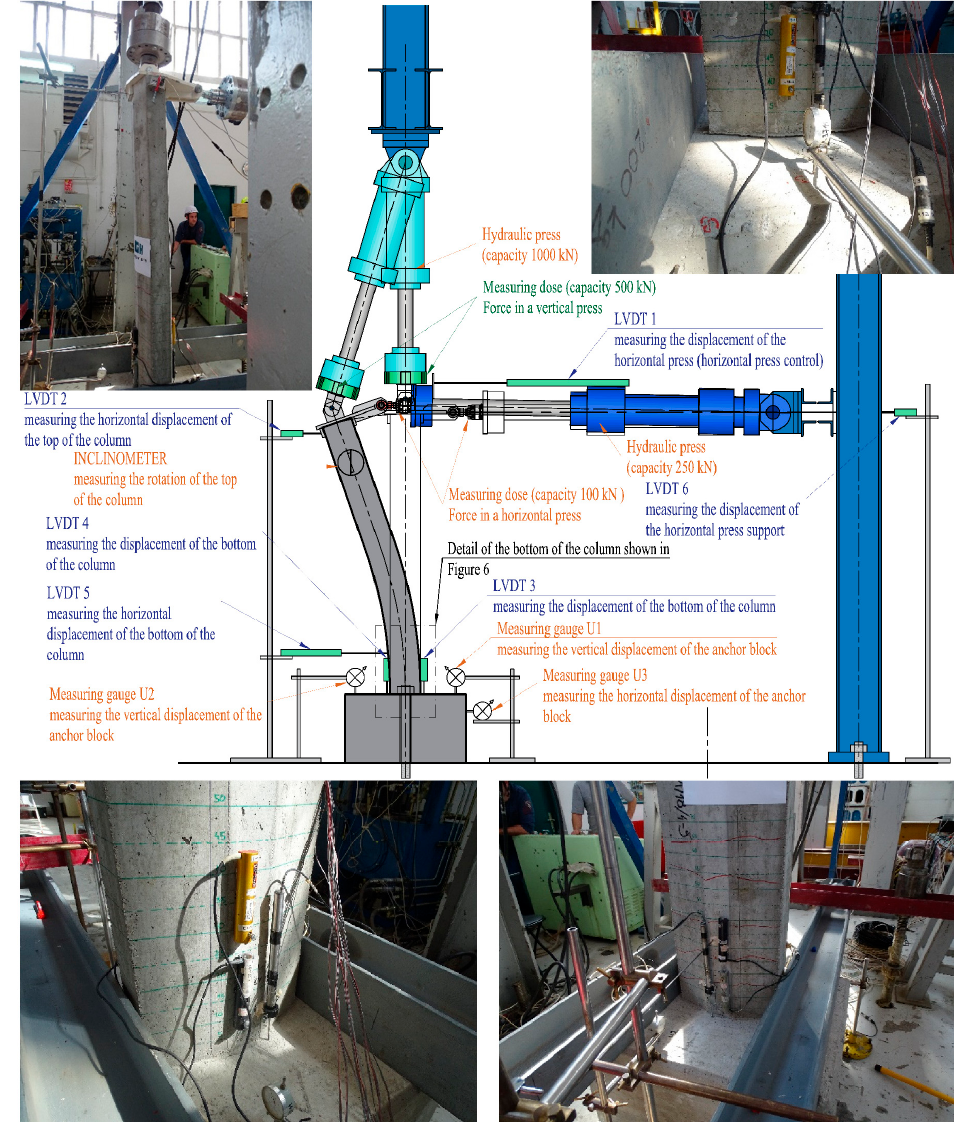
Figure 6. Positions of measuring spots.